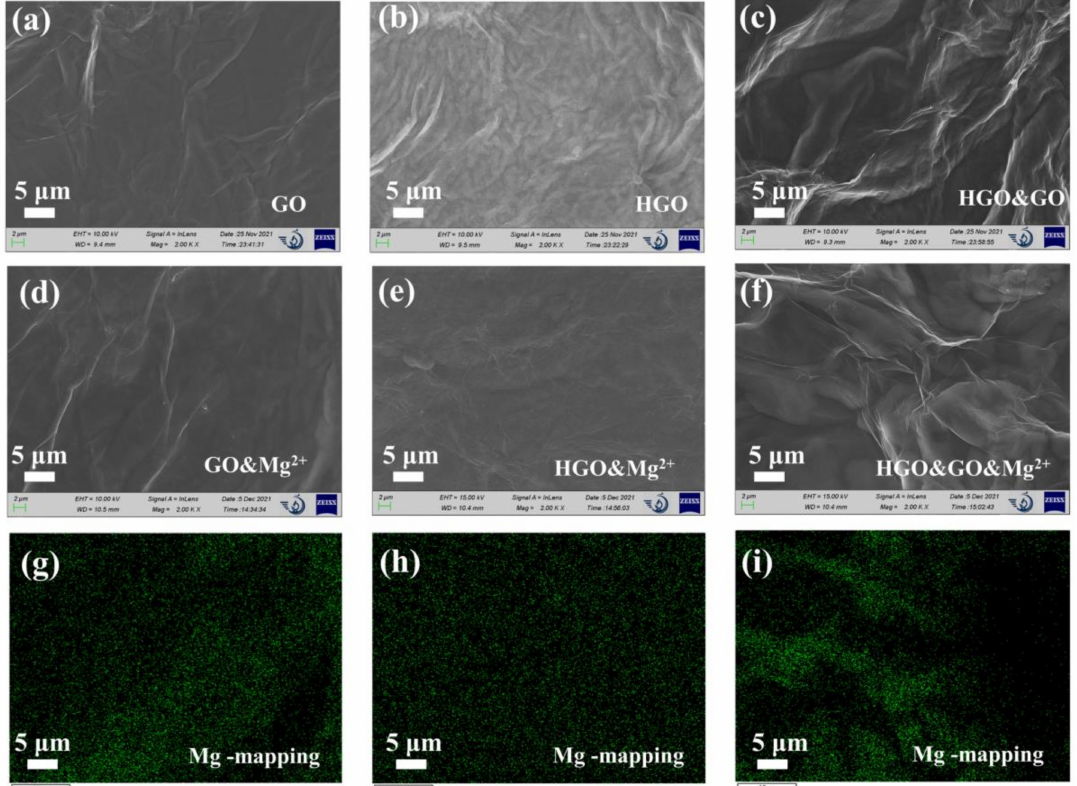
Figure 3. ( a – f ) Scanning Electron Microscopy (SEM) images of the GO, HGO, HGO&GO, GO&Mg 2+ , HGO&Mg 2+ and HGO&GO&Mg 2+ membranes. ( g – i ) Corresponding Mg elemental mapping de- tected in the energy dispersive X-ray (EDX) spectra of ( d – f ), respectively. The number of oxygen-containing groups in GO has a significant impact on the humidity sensitivity of GO-based humidity sensors [11]. To explore this, the FTIR spectra of GO and HGO were detected, as shown in Figure 4a. The main characteristic peaks at ~3594 cm − 1 , 1730 cm − 1 , 1622 cm − 1 and 1116–1228 cm − 1 correspond to stretching vibrations of hydroxyl (O–H) groups, carboxyl (C=O) groups, aromatic ring (C–C/C=C) and epoxy (C–O–C) groups [28,30,31], respectively. Obviously, the intensity of the absorption peak after normalization in GO is weaker than that in HGO at 3594 cm − 1 , 1730 cm − 1 , 1622 cm − 1 and 1116–1228 cm − 1 , which shows that the oxygen content of the former is lower than that of the latter. It can be concluded that a high reaction temperature is beneficial for further intercalation of oxidized groups, which also promotes the exfoliation of graphite oxide into smaller GO sheets. This is identified with the results of AFM. Figure 4b,c show the full scan XPS spectra of HGO and GO. Obviously, the former contains more oxygen than the latter. As shown in Figure 4c,d the proportion of oxygen-containing functional groups can be obtained according to C1s curve-fitting peak analysis. Four peaks at 284.6 eV, 286.7 eV, 287.8 eV and 288.9 eV correspond to C–C/C=C, C–O/C–O–C, C=O and O–C=O, respectively [3,19,32,33]. It can be observed that the amount of hydroxyl/epoxy in GO is lower than that in HGO, which is consistent with the FTIR